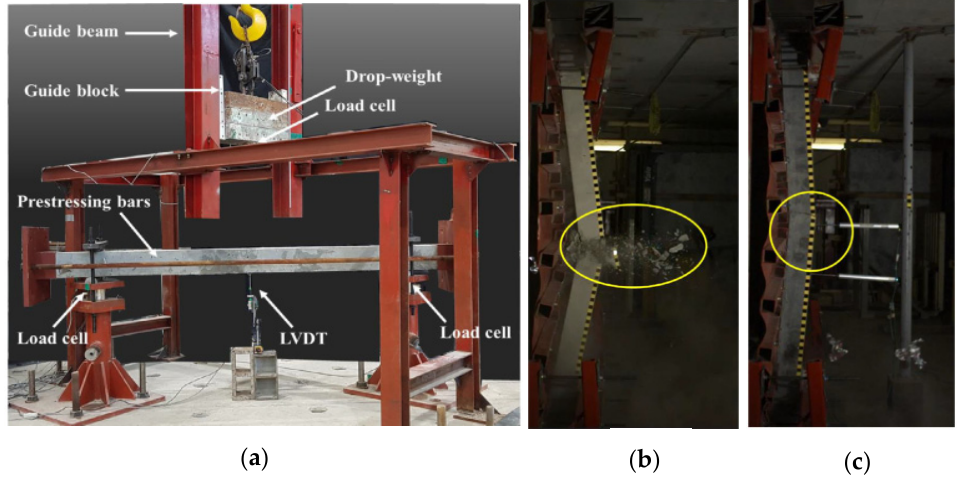
Figure 11. Impact and blast loading. ( a ) Drop-weight impact test set up, ( b ) normal strength column performance at blast and ( c ) UHPFRC-strengthened column performance at blast ([112]—Elsevier Copyright).